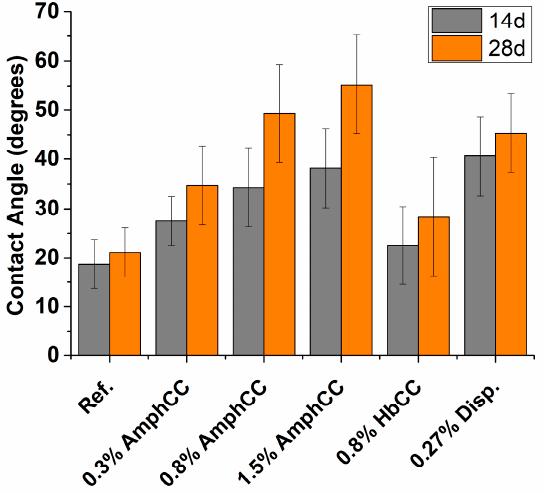
Figure 7. Contact angles of the hardened paste samples.